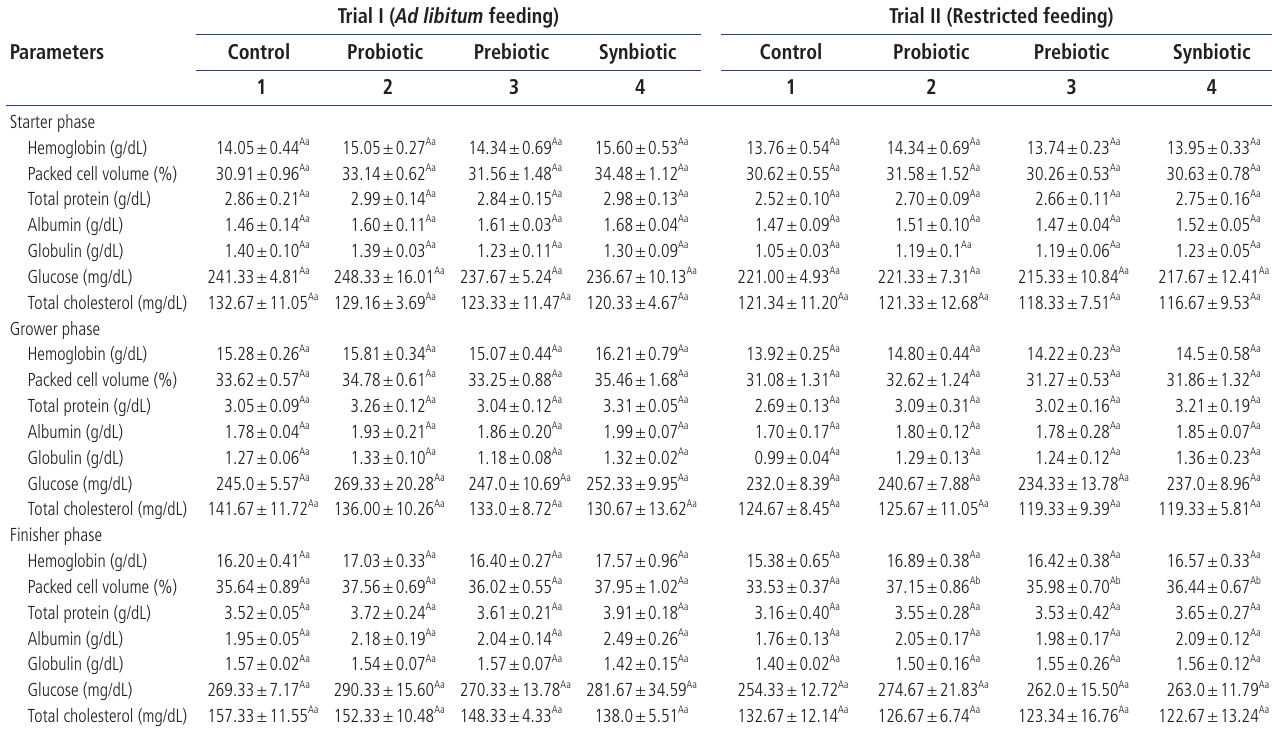
Table 4. Blood and serum biochemical indices in the different experimental groups at the end of the starter, grower and finisher periods (Mean±SEM) Trial I (Ad libitum Parameters